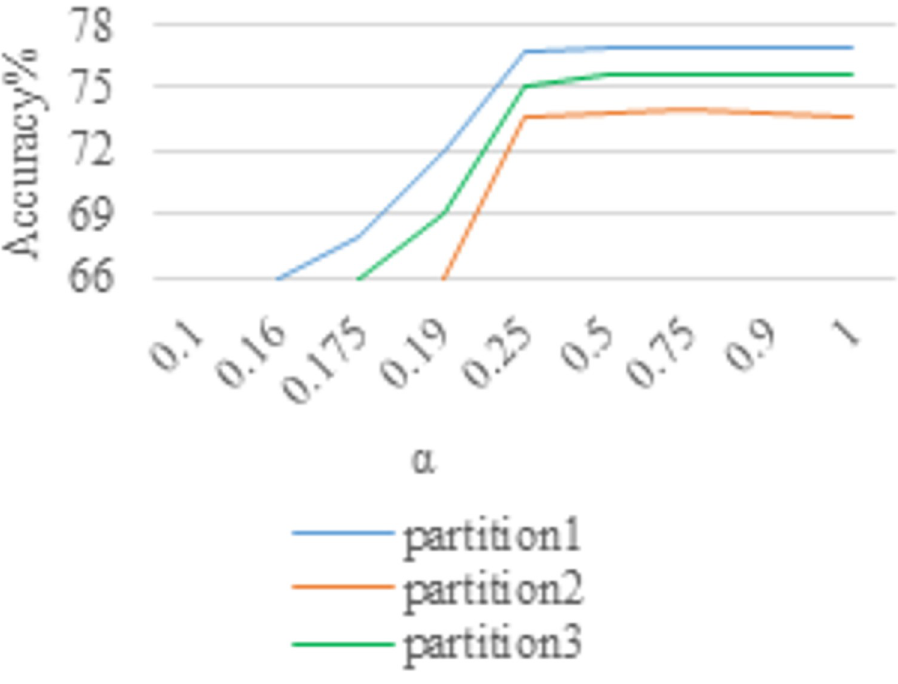
Fig 10. The influence of different values of α on HMDB-51 about accuracy.